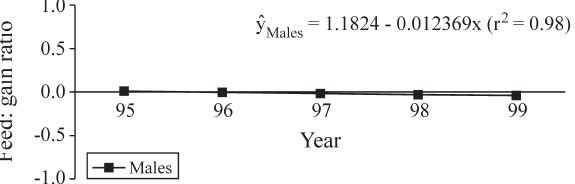
Figure1 -Directgenetictrendsforthefeed:gainratiofrom1995to1999.